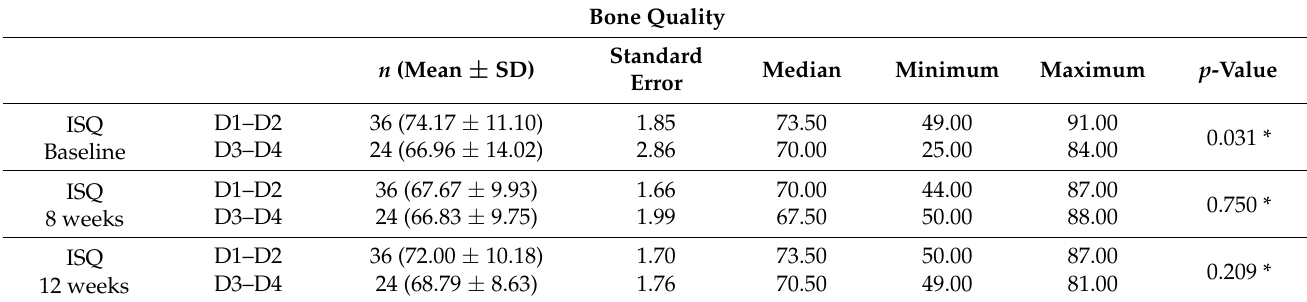
Table 3. ISQ values as a function of bone quality at baseline, 8 weeks, and 12 weeks.